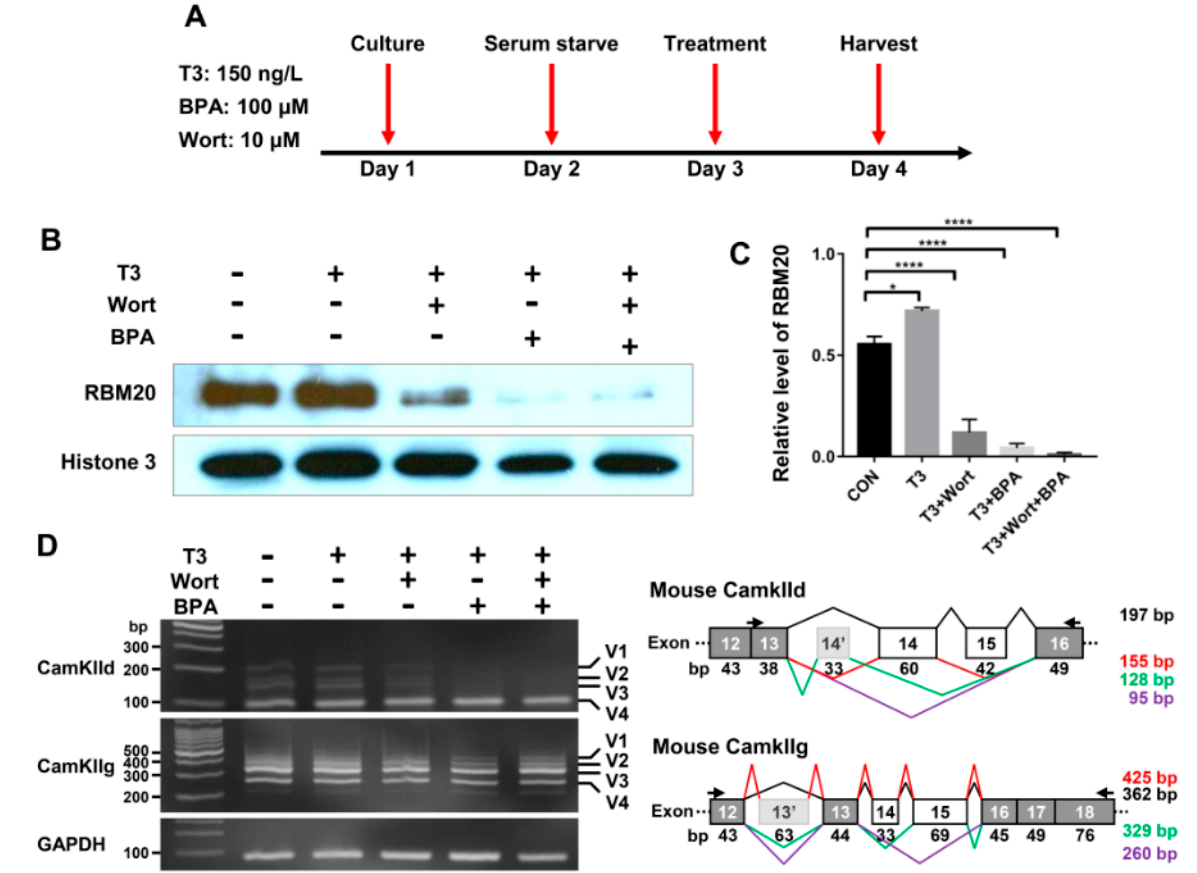
Figure 5. RBM20 expression and pre-mRNA splicing of CamkIId and CamkIIg in undifferentiated C2C12 cells via the genomic and non-genomic pathways. ( A ) Treatment timeline of C2C12 cells with T3, Wort and BPA; ( B ) Western blotting of RBM20 expression in C2C12 cells treated with T3, Wort and BPA respectively; ( C ) Quantification of RBM20 expression level. ( D ) RT-PCR detection of pre-mRNA splicing of CamKIId and CamKIIg genes in C2C12 cells treated with T3, Wort and BPA respectively. CON, control; T3, trriodothyronine; Wort, Wortmannin; BPA, Bisphenol A; V1-4, splicing variants of CamkIId and CamkIIg; Histone, protein loading control. Mean ± SEM ( n = 5), * p < 0.05, **** p <